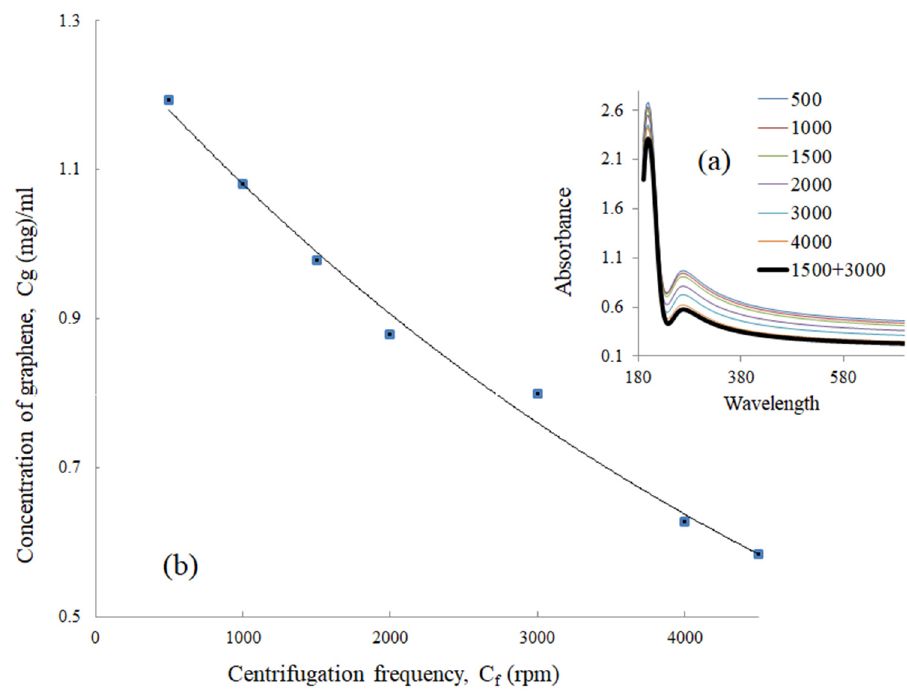
Figure 4. ( a ) The UV absorption spectra for different centrifugation frequencies, C f ; ( b ) C f vs. C g curve for 0.2 mL dispersion in 5 mL DI water. Here, the centrifugation 1500 rpm for half an hour followed by another 3000 rpm for half an hour is considered as 4500 rpm in the graph.